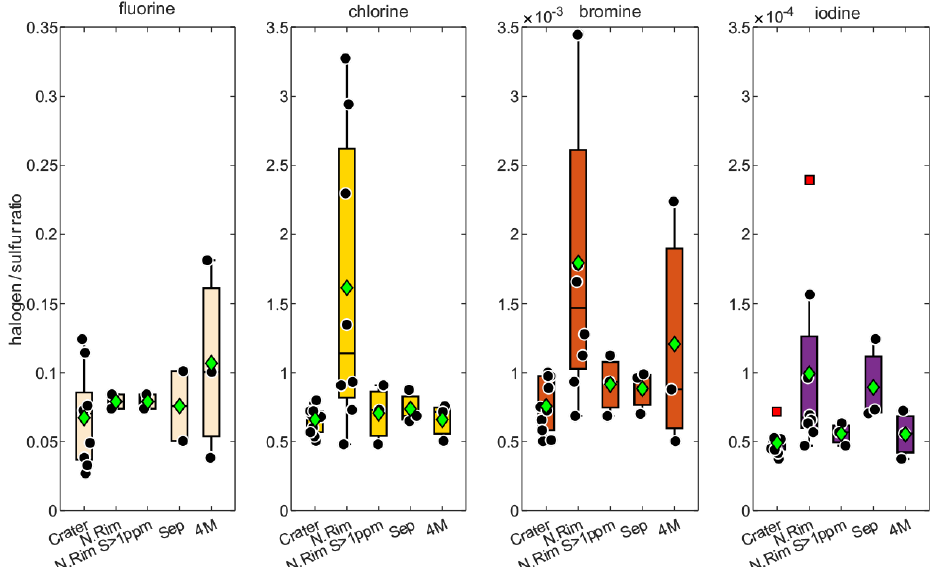
Figure 3. Evaluation of the measured halogen to sulfur ratios for the Crater:Raschig tube in July at Santiago crater, the N.Rim:RT in July at Nindirí rim, the N.Rim S > 1ppmv:RT in July at Nindirí rim without samples with less than 1ppmv sulfur, the Sep:RT in September at Santiago crater, and the 4M:Drechsel bottle samples in July at Santiago crater with 4M NaOH solution. For each box, the black dots are the individual data points, the central mark is the median, the green diamond is the mean, the box extends vertically between the 25th and 75th percentiles, the whiskers extend to the most extreme data that are not considered outliers, and the outliers are plotted individually marked by red